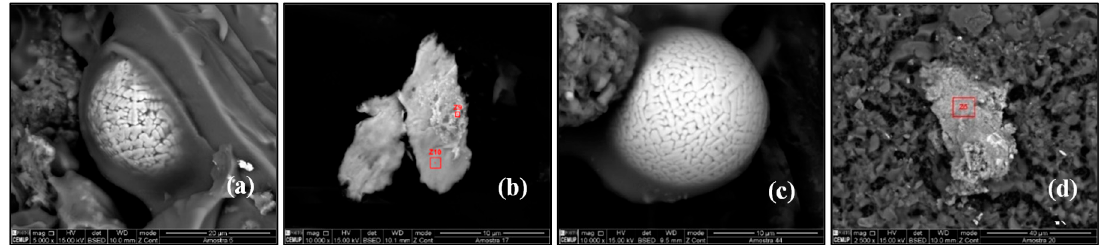
Figure 11. Scanning electron microscopy images of ( a ) chromium particle, ( b ) tin particles, ( c ) iron oxide particle, and ( d ) zinc oxide particle.